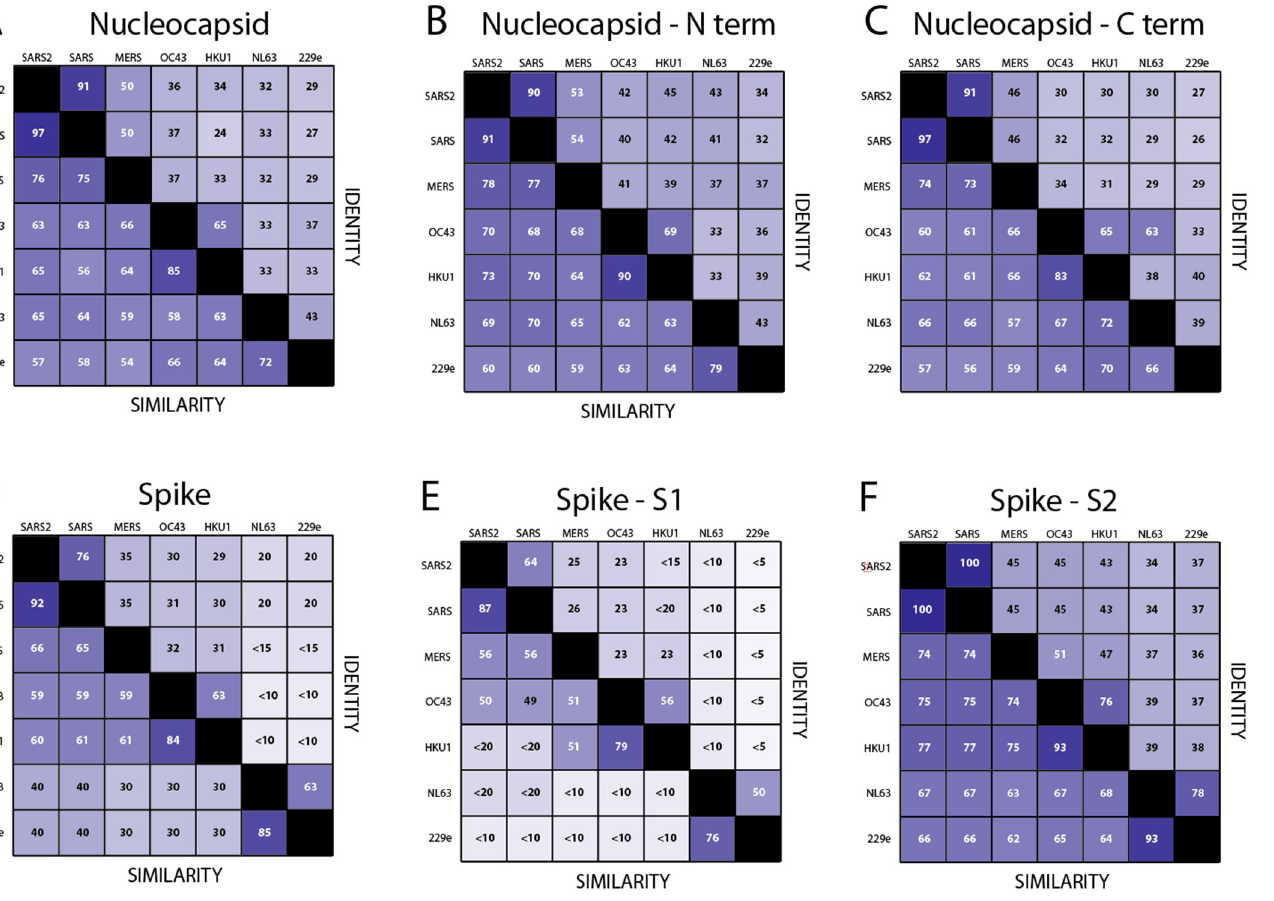
Figure 7. Sequence identity and similarity of nucleocapsid and spike across the Coronaviridae family. The percentage of identical and chemically similar amino acids are indicated in ( A ) across the entire N proteins. Shading is proportional to the percent identity or similarity. ( B ) shows the amino terminal (N-term) sequences of the N proteins. ( C ) shows the carboxyl-terminal (C-term) sequences of the N proteins ( D) across the entire spike proteins. ( E ) S1 subunit sequence of the S proteins and ( F ) S2 subunit sequence of the S proteins.